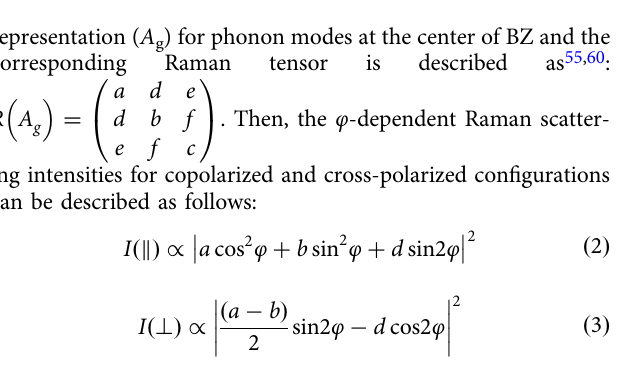
Fig. 4 Ultrastrong and anisotropic third-order nonlinear optical response in 1D vdW FRP. a THG intensities as a function of the excitation power with a fundamental pulse wavelength of ~ 1300 nm. The inset is the schematic diagram for the THG process. b Upper panel: THG spectra as a function of ¼ R sample (cid:2) R substrate generated photon energies. Lower panel: the re fl ectance contrast spectrum 4 R of 1D vdW FRP, 4 R , where R sample and R substrate are the R substrate R R re fl ected spectra measured from the sample and substrate, respectively. c Comparison between the THG intensity of 1D vdW FRP and other well-known materials (e.g., GaAs, Si, gold, and few-layer MoS 2 ) with large third-order nonlinear optical responses under the same excitation conditions. The THG intensities of GaAs, Si, gold and few-layer MoS 2 thin fi lms are multiplied by a factor of 3, 30, 15, and 10, respectively, for comparison. d Polar plots of THG intensity versus the polarization angle θ for co-polarized (red) and cross-polarized (blue) con fi